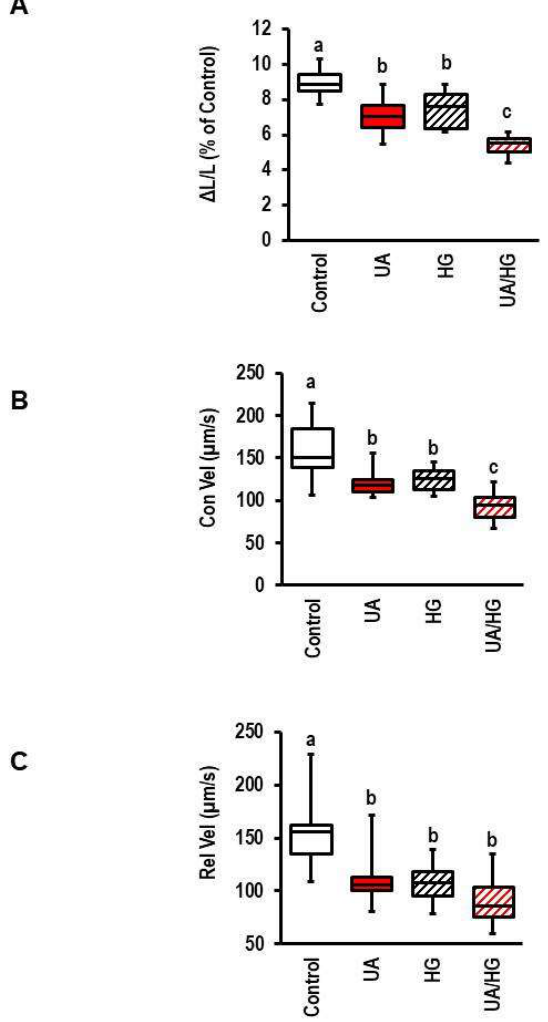
Figure 8. Effect of hyperglycemia on uric-acid (UA)-induced effects on cell shortening. Cells were exposed to UA (3 mg/dL) and glucose (15 mmol/L; HG) for 24 h before analyzing cell shortening. Data show the effects on cell shortening (( A ); ∆ L/L), contraction velocity (( B ); Con Vel), and relaxation velocity (( C ); Rel-Vel). Data are expressed as bars and whiskers with median, 25% quartile, 75% quartile indicated by bars, and complete range by whiskers. Statistical analysis is based on Student t -tests and exact p -values are indicated. Data are means from n = 10 (each) preparations (rats), with 4 cell culture dish per preparation and 9 cells evaluated per cell culture dish. Statistical analysis is based on preparations. Equal letters (a, b) indicate sample groups with p > 0.05. Different letters indicate p <